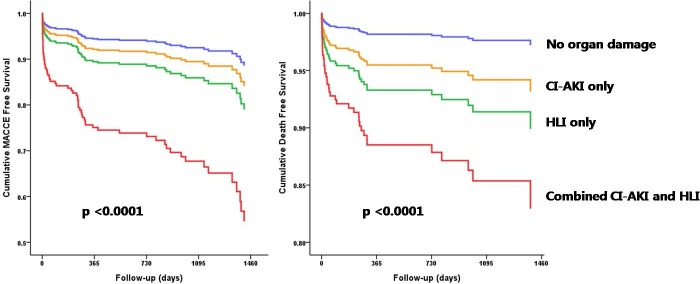
Survival probability plots of MACCE and all cause mortality according to CI-AKI and HLI state after adjustment for age, diabetes mellitus, hypertension, MVD, Killip class, and LVEF using Kaplan-Meier method.Abbreviations MACCE = major adverse cardiovascular and cerebrovascular event; CI-AKI = contrast induced acute kidney injury; HLI = hypoxic liver injury; MVD = multi-vessel disease; LVEF = left ventricular ejection fraction.